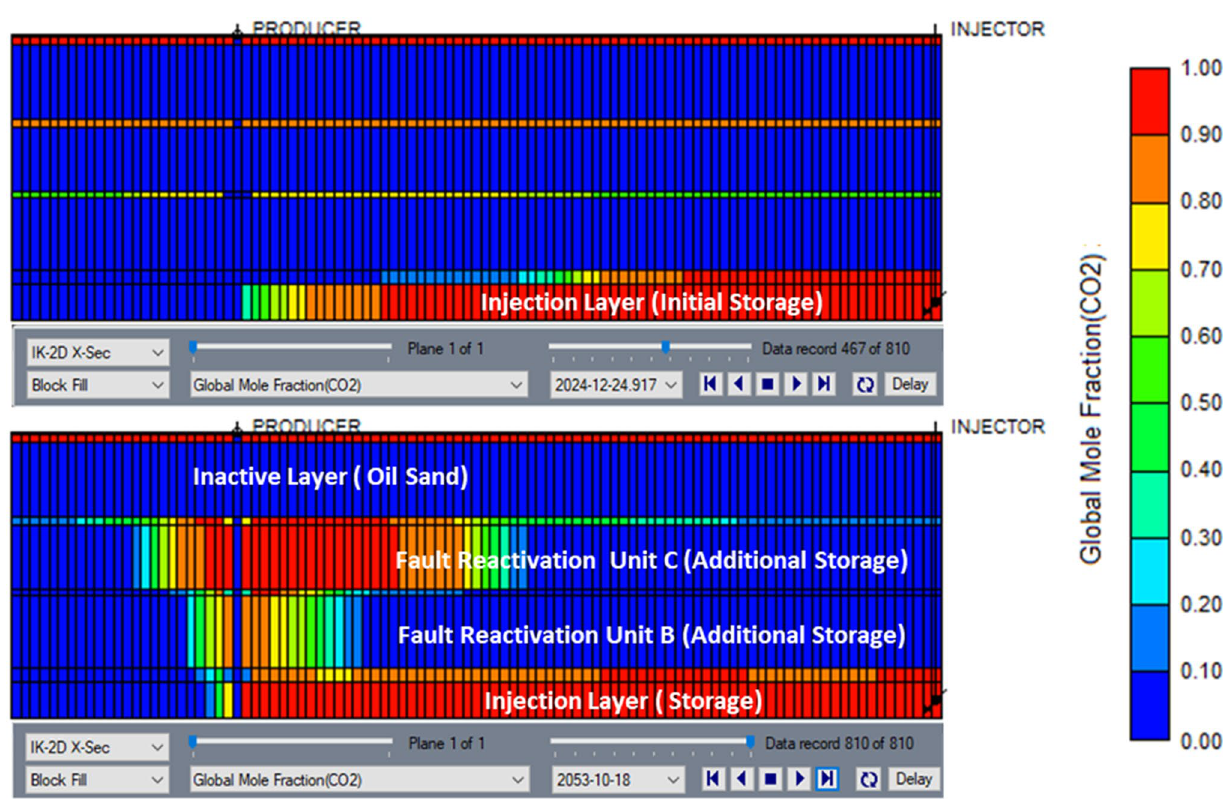
Fig. 17 Depiction of an increase in storage volume for carbon dioxide due to fault